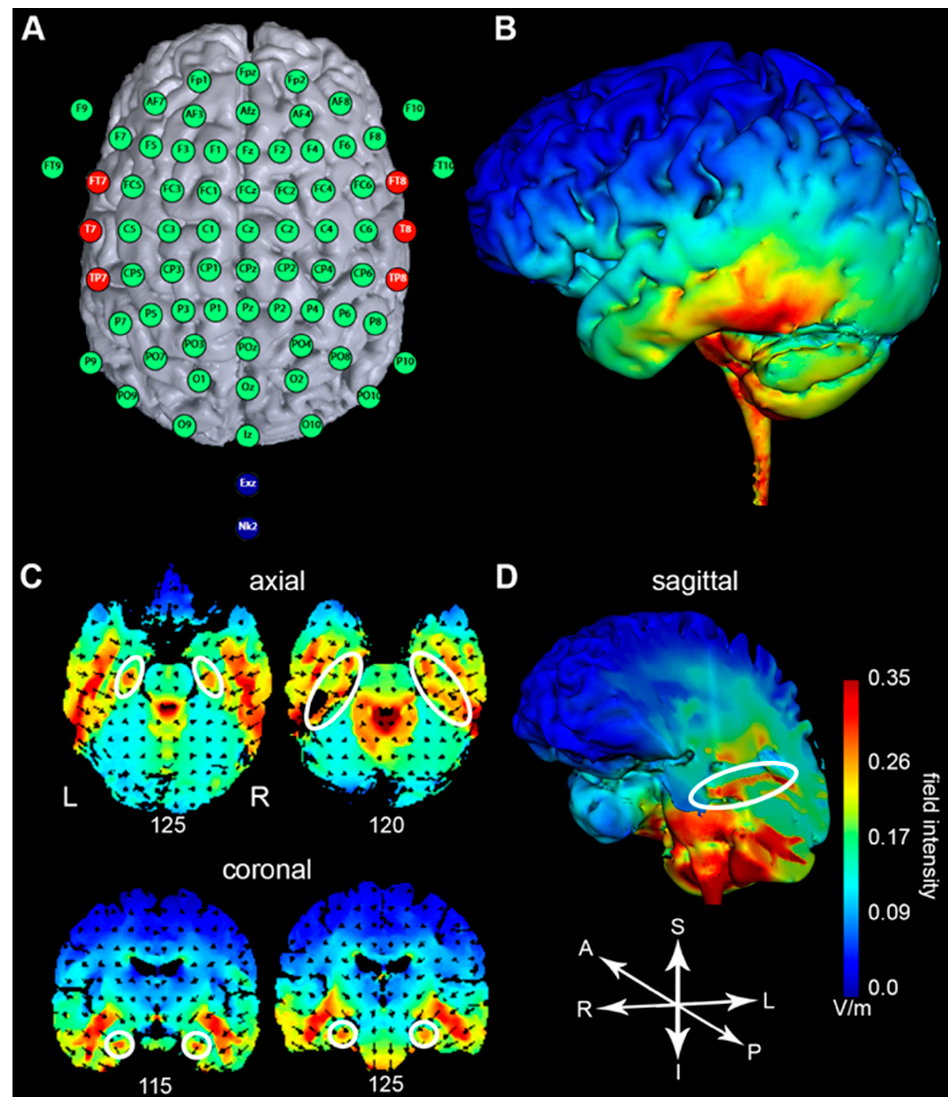
Figure 2. ( A ) Schematic transcranial direct-current stimulation (tDCS) montage integrated into an electroencephalogram (EEG) 10–20 montage. Note that the high-resolution EEG montage displayed in this figure was used only for anodal tDCS electrode location specification for current density simulation. This virtual EEG montage does not correspond to the recording EEG montage of this study (see Figure 3). ( B ) The lateral view of the left hemisphere shows higher electrical field intensity at the middle and inferior temporal gyri. ( C ) Axial and coronal slices illustrating higher simulated electrical field intensities in hippocampal areas (white ellipses and circles). ( D ) Sagittal cut along the hippocampus shows simulated higher electric field intensity (white ellipse). A = anterior; I = inferior; L = left; P = posterior; R = right; S = superior.